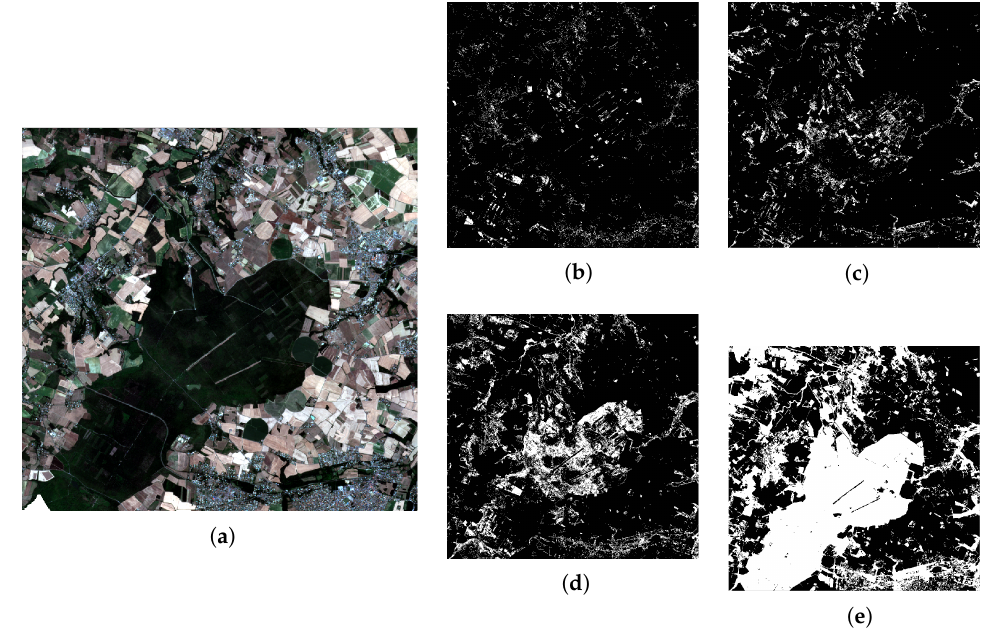
Figure 10. A first visual evaluation zone with ( a ) its RGB composite and the corresponding binary classification maps for ( b ) RF PUL , ( c ) ENSEMBLE PUL , ( d ) OCSVM, and ( e ) PUL-SITS for the positive class Forest with the number of positive training data objects ( n ) equal to 80.